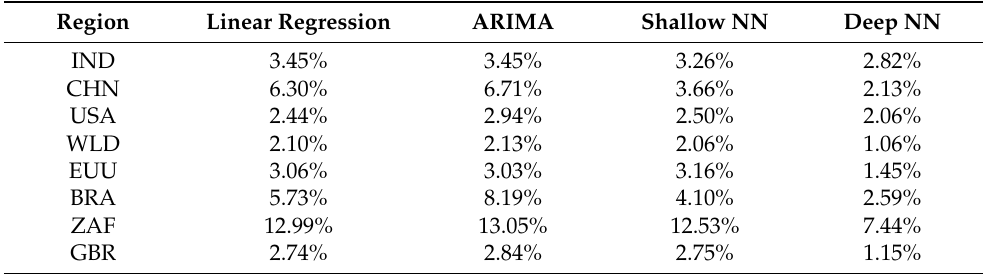
Table 3. The mean average percentage error (MAPE) on the training set, per region and model, is under a polynomial degree of three.